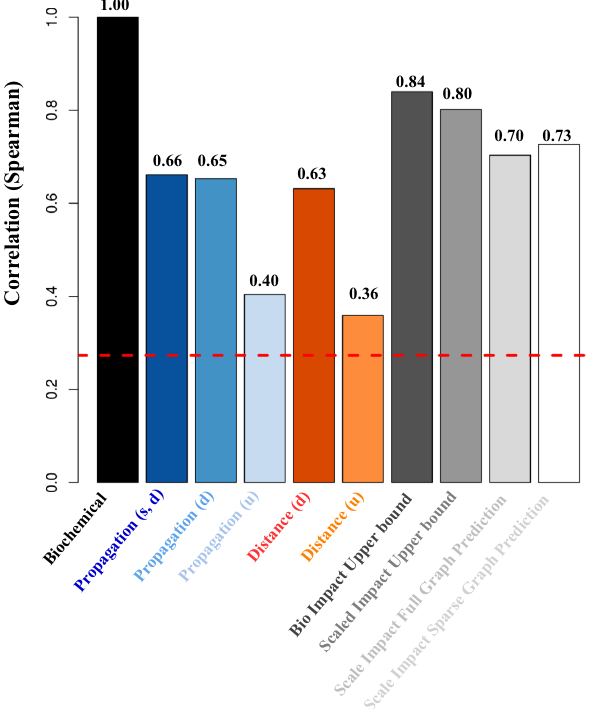
Figure 3. Overall results on perturbation pattern prediction.